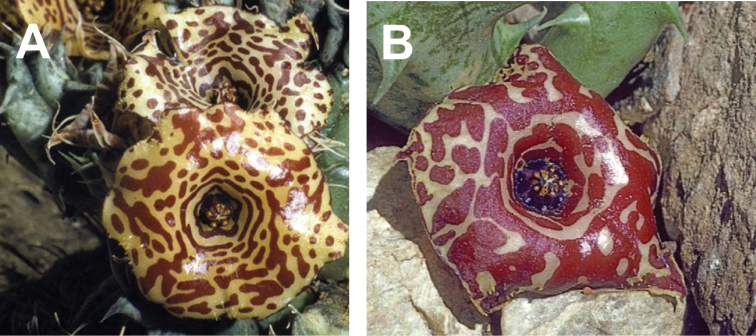
Ceropegia
laevis, Jabal Qahar, 90 km NE of Baysh, Jazan, Saudi Arabia ACollenette 8177B ex S Collenette 8180 sub DP8296. Reproduced from Plowes (2014).